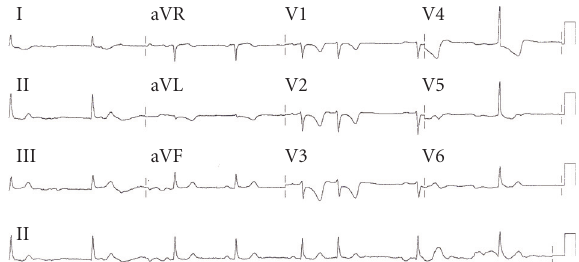
Figure 1: ECG demonstrating Inferior ST elevation, T wave inversions.